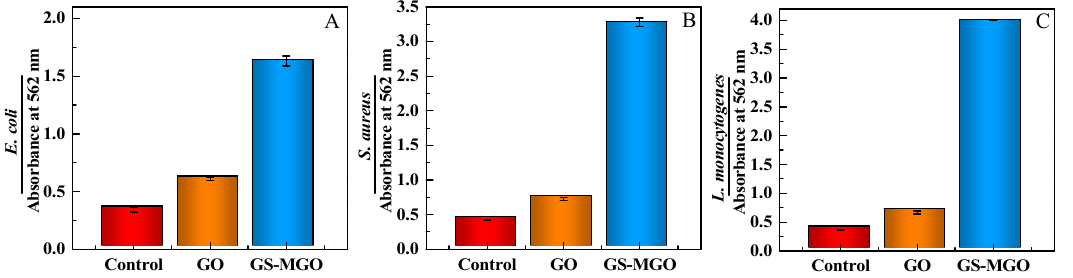
Figure 8. The absorbance values of leaked proteins treated with the control, GO, and GS-MGO nanohybrids against E. coli ( A ), S. aureus ( B ) and L. monocytogenes ( C ).